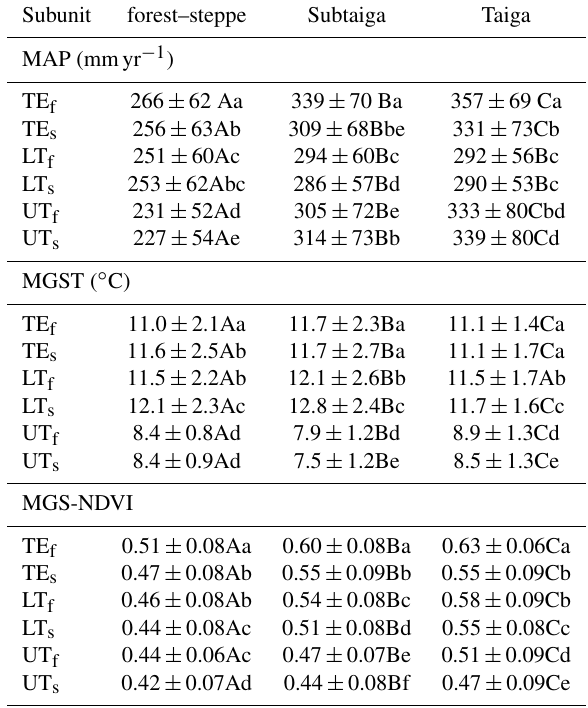
Table 1. Arithmetic mean ± standard deviation of different climate parameters (MAP: mean annual precipitation, MGST: mean grow- ing season temperature, MGS-NDVI: mean growing season normal- ized differentiated vegetation index) and vegetation units (subunits are TE: total ecological unit, LT: lower treeline, UT: upper treeline, s: portion of grassland, f: portion of forest). Within one row, mean values sharing a common uppercase letter, do not differ significantly ( p ≤ 0 . 05, Duncan’s multiple range test, df model = 2). Within one subunit (forest–steppe, subtaiga, taiga), mean values sharing a com- mon lowercase letter do not differ significantly ( p ≤ 0 . 05, Duncan’s multiple range test, df model = 5 .